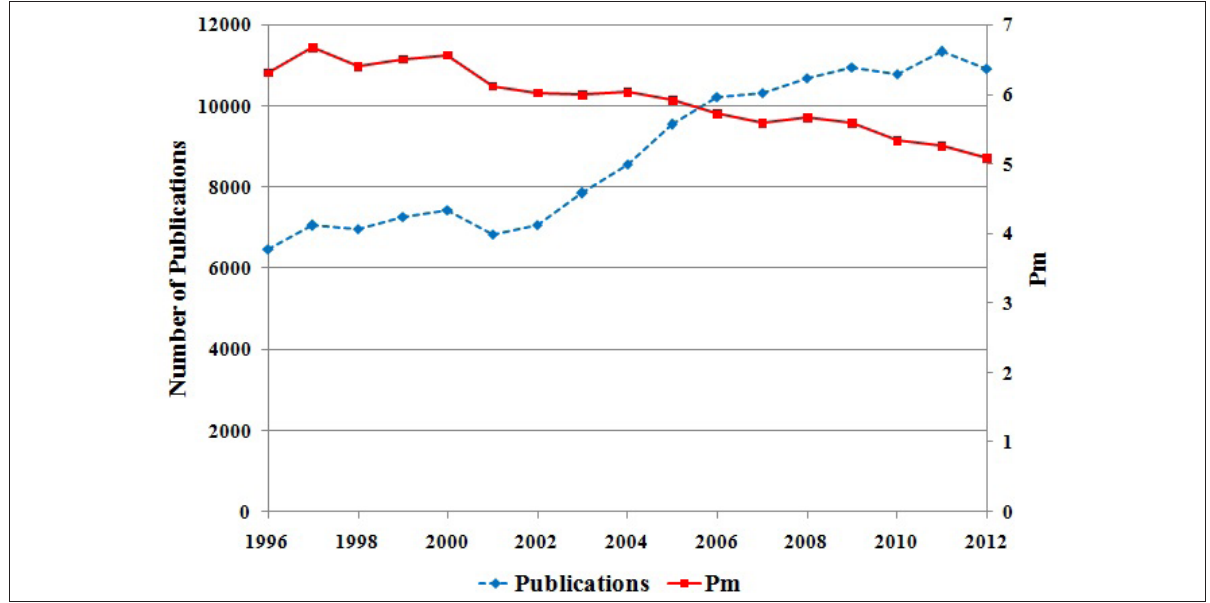
Blue dashed line = number of publications; red solid line = Pm value Figure 1: Temporal evolution of number of publications and Pm value for France compared with world average. To produce the diagram, each country’s pair number (Pm,Cm) for every year is shown by a dot on the diagram. The Pm and Cm values are represented on the vertical and horizontal axes respectively. By evolution line of a country can be drawn. The data needed for this study